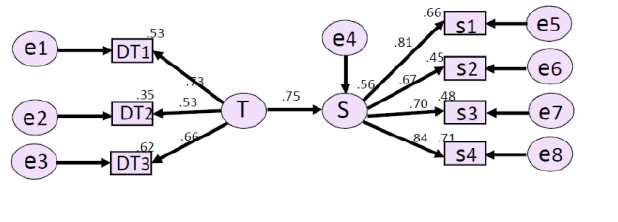
Fig. 7: Structural Equation Modeling (SEM) for Transparency and Service